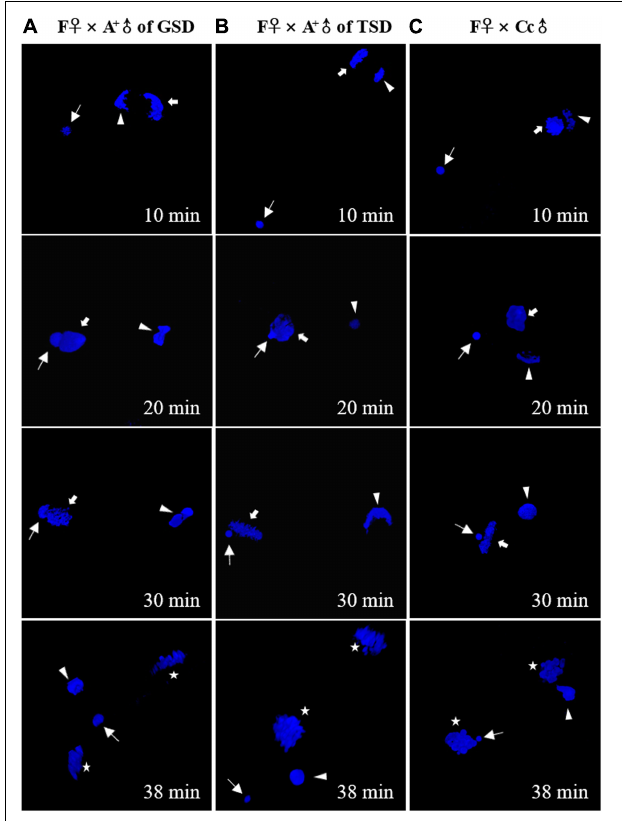
FIGURE 4 | Nuclear behaviors in the fertilized eggs stained by DAPI. (A–C) The fertilized eggs of F mating with A + of GSD (A) , A + of TSD (B) , and Cc (C) . Thin arrows indicate sperm nucleus. Thick arrows indicate female ♀ ♂ ♂ pronucleus. Arrowheads indicate second polar-body. Asterisks indicate the ♂ nucleus of zygote after the first mitosis. The female pronucleus and the second polar-body are distinguished by the morphology. The corresponding time after fertilization is showed at the right corner.